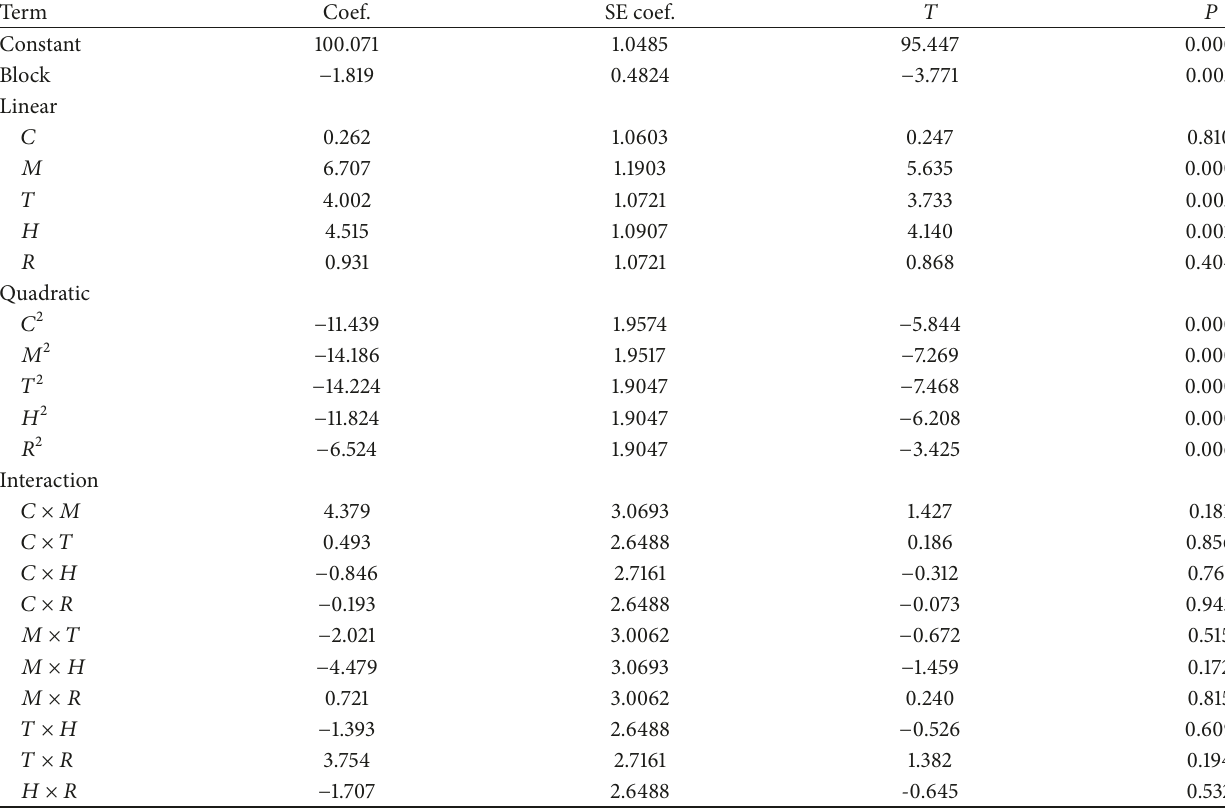
Table 3: Estimated response surface regression coefficients for optimal JME yield using uncoded units. Term